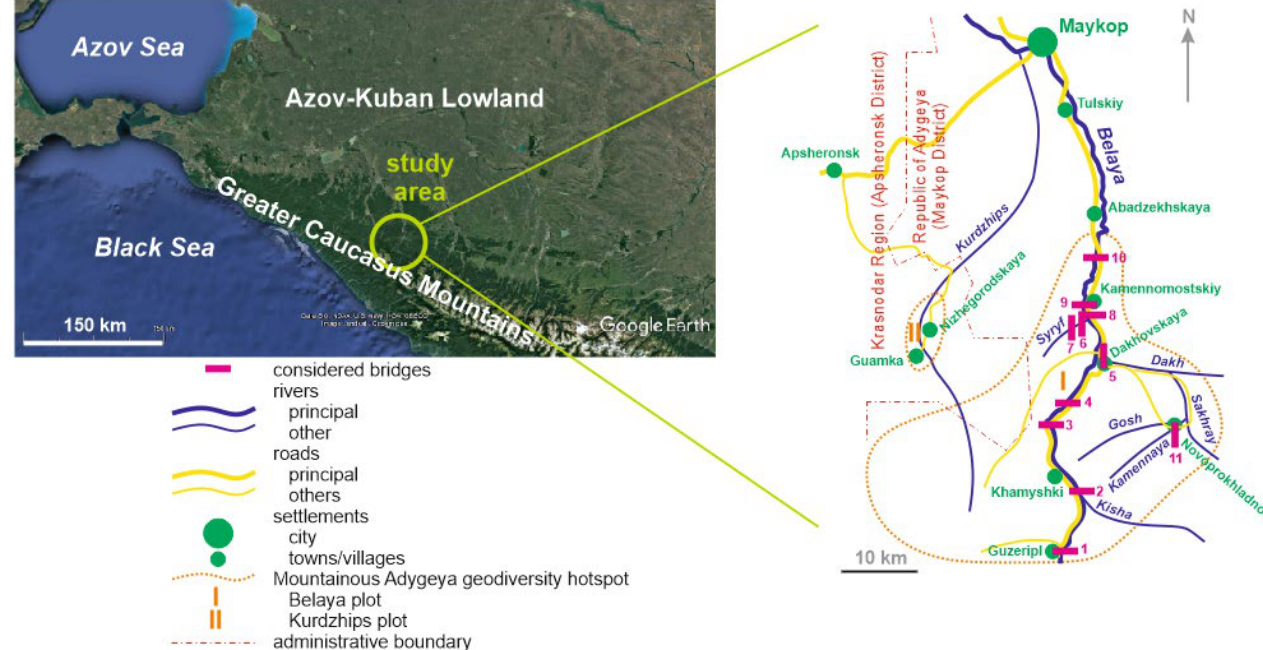
Figure 1. Location of the study area and its bridges. Inserted image was generated from the Google Earth engine.